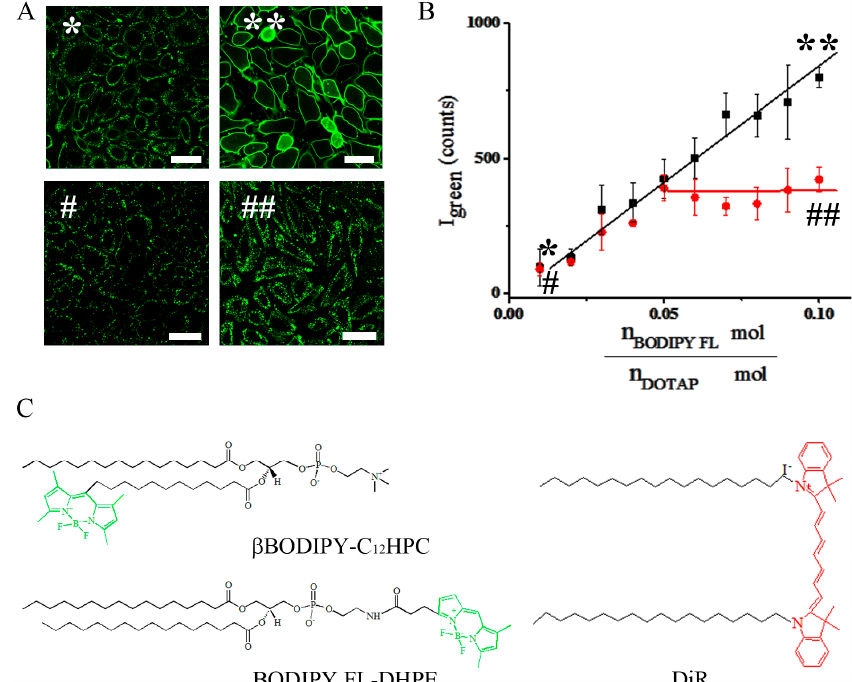
Figure 4. Importance of the aromatic component. ( A ) Fluorescence micrographs of CHO cells treated with liposomes containing BODIPY FL-DHPE as aromatic component in fusogenic liposomes (FL) at 0.01 (*) and 0.1 (**) mol/mol concentration as well as in endocytotic liposomes (EL) at the same concentrations (# and ##). Scale bars, 20 µm. ( B ) Dependence of fusion efficiency on dye concentration in FLs (black) and in ELs (red) determined by flow cytometry. The signal intensity median of the whole cell population was plotted vs. BODIPY FL-DHPE molar ratio to the cationic DOTAP amount in the liposomes (n Bodipy FL-DHPE /n DOTAP mol/mol). Measurement points with standard deviations are shown as squares (FL) and circles (EL), respectively. Lines represent linear fits. ( C ) Molecular structures of the chain labelled lipid β BODIPY-C 12 HPC, the head labelled lipid BODIPY FL-DPHE, and the lipophilic membrane dye DiR incorporated in FLs as fluorescent components. The aromatic molecular parts are coloured green and red, representing their spectral emissions. Results for β BODIPY-C 12 HPC and DiR are shown in Supplementary Figures S1 and S2.